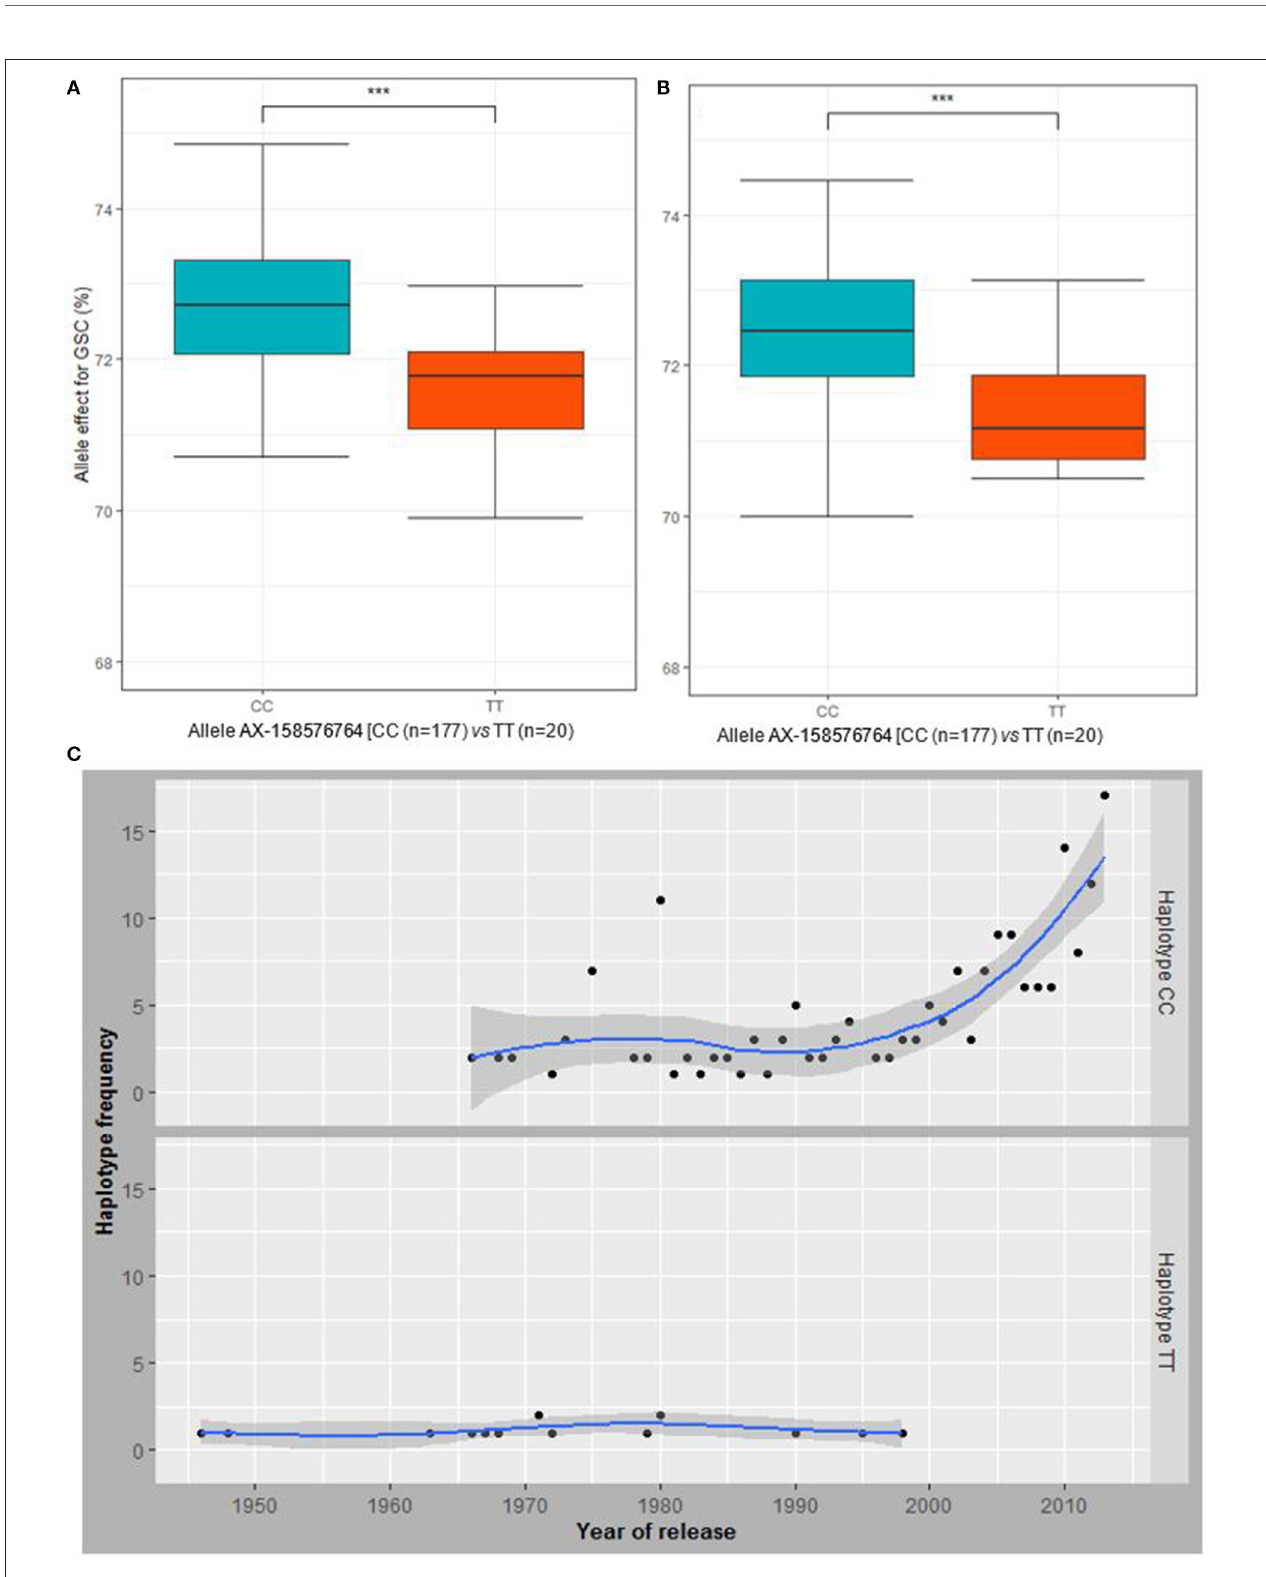
FIGURE 6 | Allele AX-158576764 effect on GSC under (A) rainfed and (B) drought conditions. (C) The trend in the allele frequency of the haplotype block including the markers AX-158576764 and AX-111076088 over years of release of the cultivars is displaying an increase in the haplotype frequency (number of cultivars) having the favorable alleles or haplotype (CC). ***means the P-value is significant at 0.001.